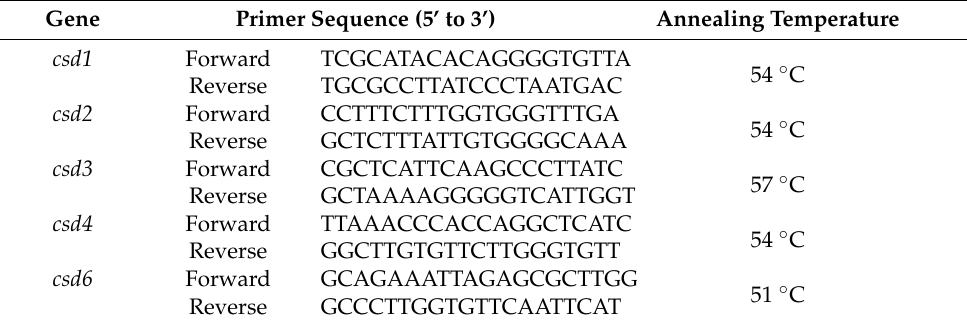
Table 2. Primer sequences used during the quantitative RT-PCR (RT-qPCR).